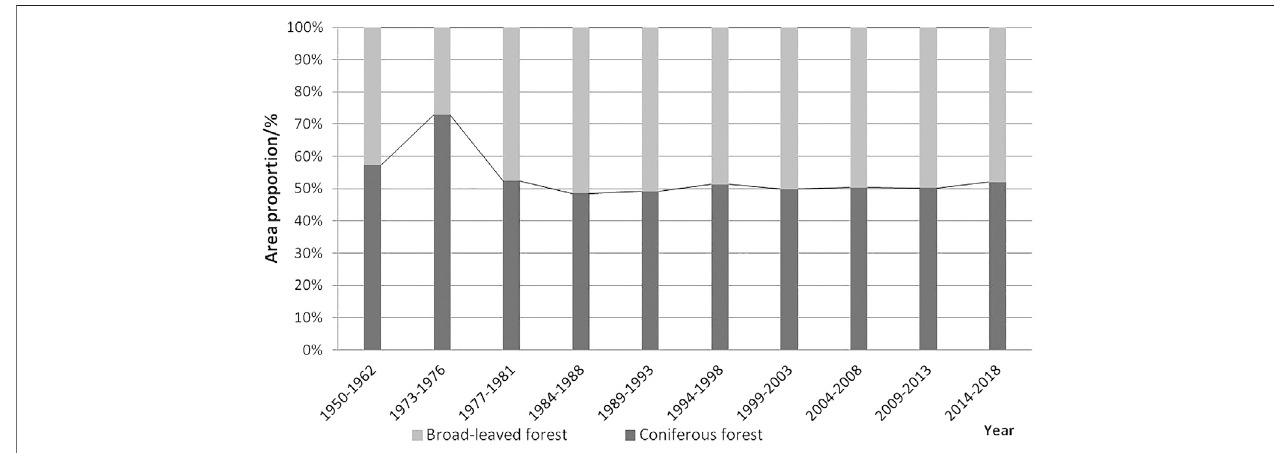
FIGURE 6 | Forest area proportion of broad-leaved forest and coniferous forest.